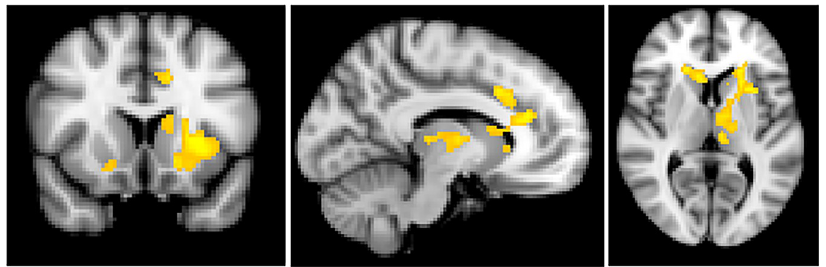
Fig 6. Whole brain activation as a function of illness course. Patterns of activation were compared based on the course of illness as collapsed into 4 levels (higher levels indicate more stable illness course). With increased duration of illness, there was decreased activation in the medial prefrontal cortex and dorsal anterior cingulate cortex, bilateral caudate and putamen, left thalamus and insula, and cerebellum in the contrast of whole body images > scrambled images. Slices are shown at Y = 14 (left), X = -10 (middle), and Z = 6